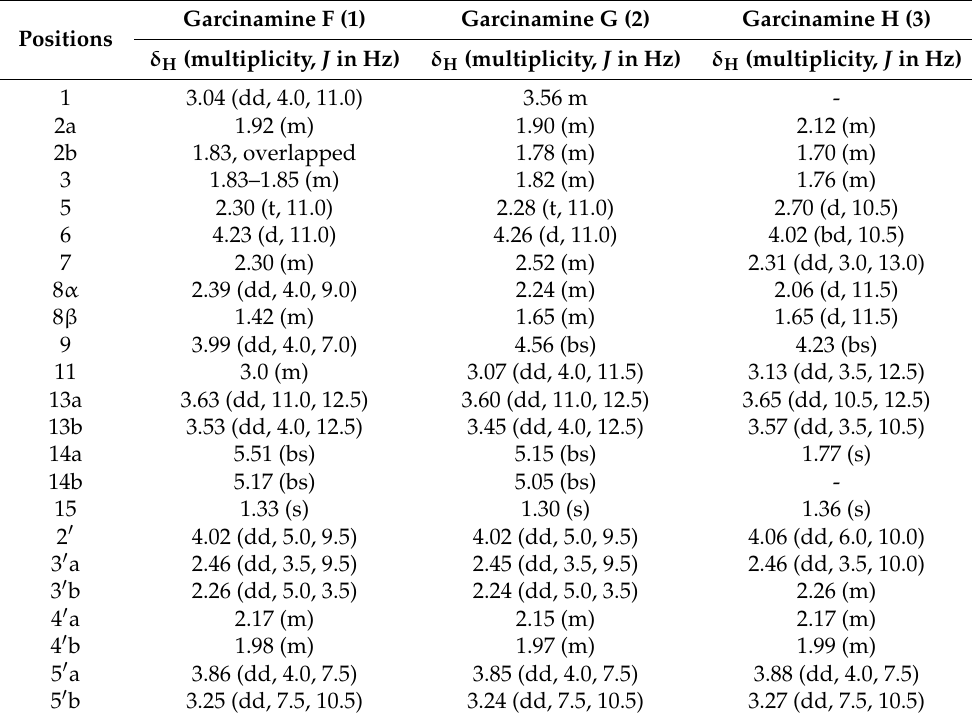
Table 2. 1 H (500 MHz) NMR data for garcinamines F–H ( 1 – 3 ) in CD 3 OD.